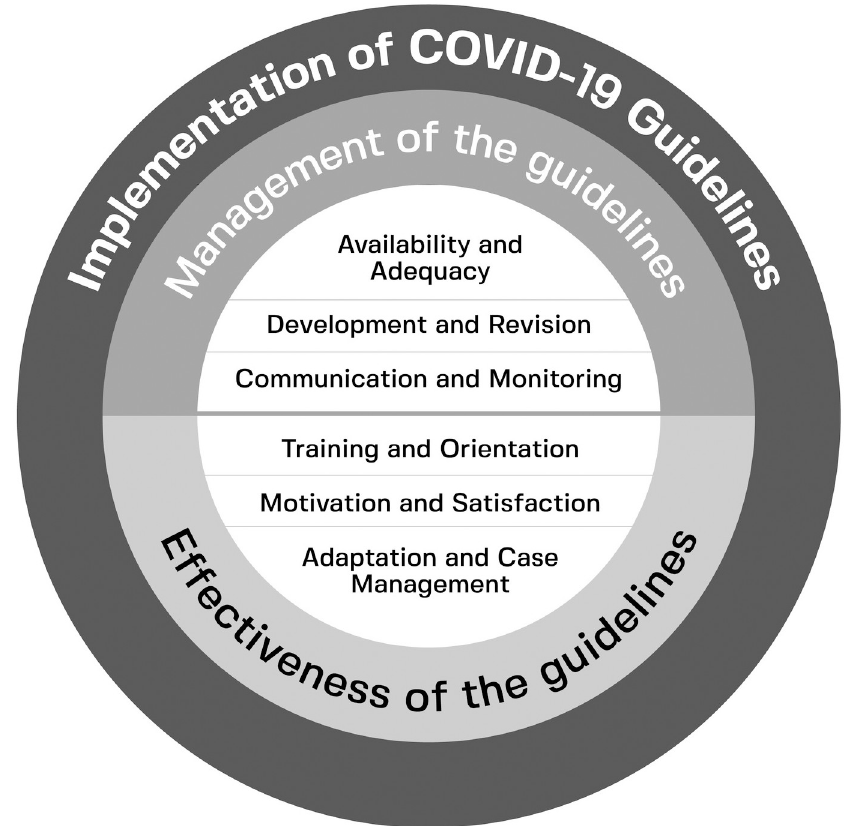
Fig 1. Pictorial illustration of codebook stating theme and its